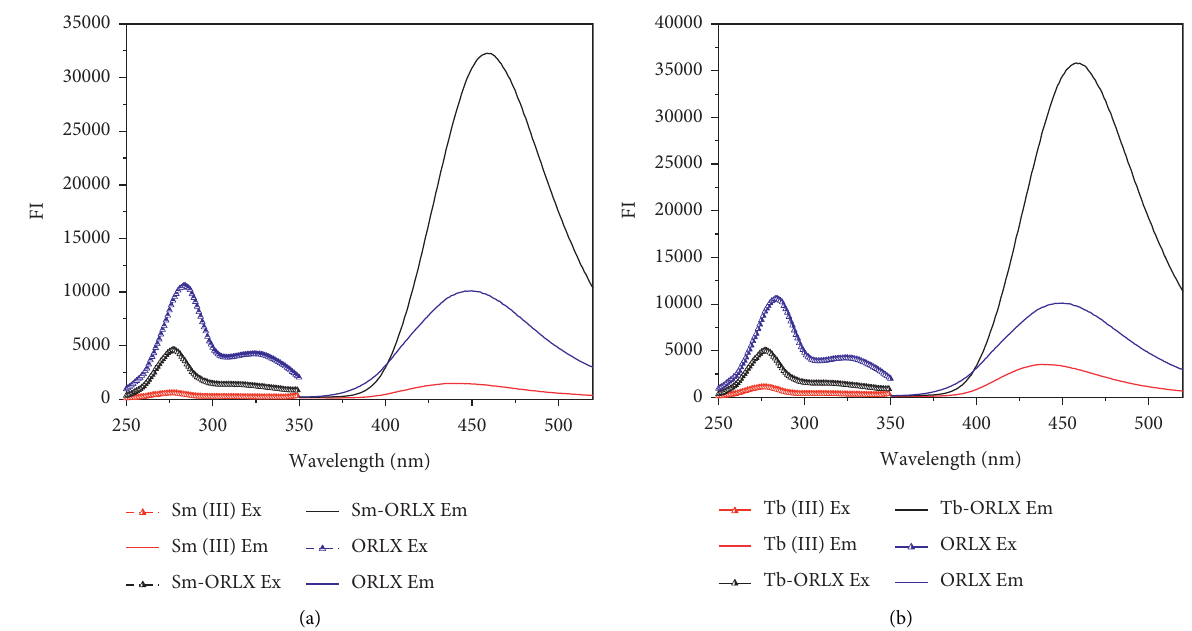
Figure 1: Excitation and emission spectra of 3 µ g/ml ORLX (a) and (b), with 30 µ g/ml Sm(III) (a) and 30 µ g/ml Tb(III) (b), measured against a